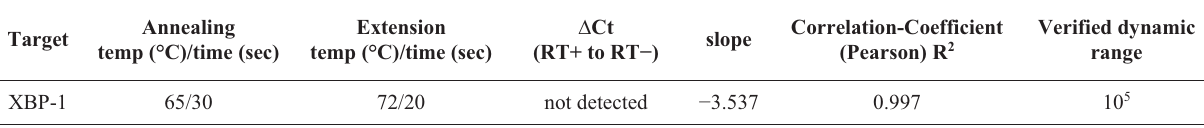
Table A2. Optimized protocol and validation studies using amplificate dilution